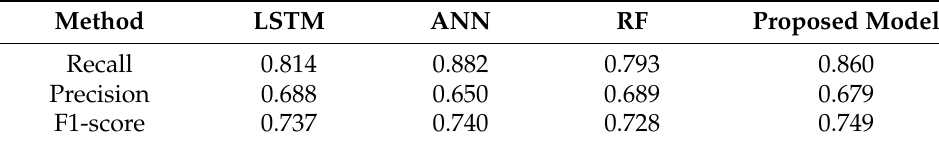
Table 3. Model prediction performances after 5 h at Location A.